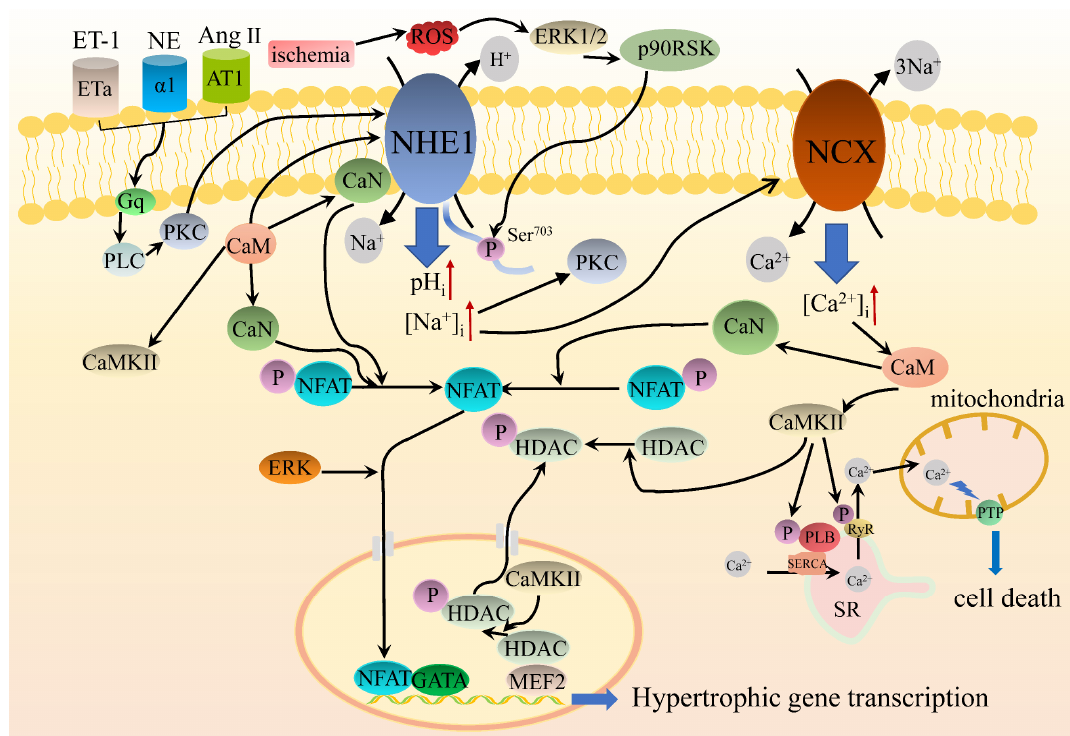
Figure 2. Diagrammatic representation of the main intracellular signaling pathways of NHE1 regulating cardiac hypertrophy. The activation of NHE1 by Gq protein-dependent phospholipase C (PLC) and subsequent Na + overload is likely to be a crucial promotor of cardiac hypertrophy induced by various stimuli such as endothelin 1 (ET-1), norepinephrine (NE), and angiotensin II (Ang II) acting on their respective receptors. Increases in reactive oxygen species (ROS) production caused by cardiac ischemia may be involved in the activation of the ERK1/2-p90RSK pathway and therefore interact with the phosphorylation of serine 703. Ca 2+ /CaM activates NHE1 through direct interaction. NHE1 activation contributes to the increases of pH i and [Na + ] i . Increased [Na + ] i leads to sustained [Ca 2+ ] i elevation by acceleration of Ca 2+ influx through the Na + /Ca 2+ exchanger (NCX). Increased [Ca 2+ ] i activates two Ca 2+ -dependent hypertrophic signaling molecules, Ca 2+ /CaM-dependent kinase II (CaMKII) and calcineurin (CaN). Activated CaMKII mediates the phosphorylation of histone deacetylase (HDAC), relieving or derepressing myocyte enhancer factor 2 (MEF2), whereas CaN dephosphorylates the nuclear factor of activated T cells (NFAT) and interacts with the transcription factor GATA, promoting transcription of hypertrophic genes. On the other hand, activated CaMKII phosphorylates the phospholamban (PLB) to accelerate cytosolic Ca 2+ uptake via the sarcoplasmic reticulum (SR) calcium transport ATPase (SERCA), and the ryanodine receptor (RyR) to increase SR Ca 2+ release, thus augmenting the Ca 2+ handling process. The increased SR Ca 2+ leak could lead to mitochondrial Ca 2+ , which opens permeability transition pore (PTP) and ultimately results in cardiomyocyte apoptosis.